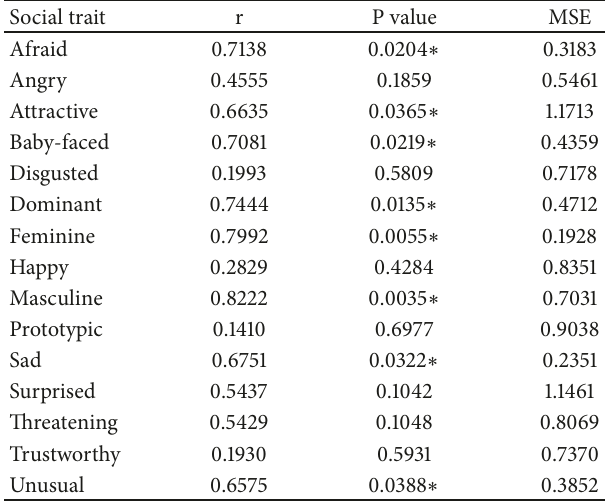
Table 3: Pearson’s r correlation coefficient, p values, and MSE between the predicted scores and the actual faces scores by social